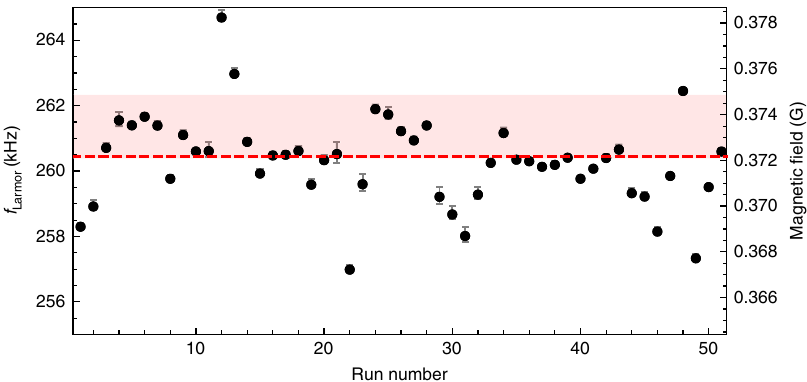
Fig. 4 Measured Larmor frequency from 51 runs. The red dashed line is the median of all observations. The horizontal light-red band represents the predicted magnetic fi eld between 85 and 100 km altitude according to the WMM2015 magnetic model 15 . Error bars are the standard error of the estimate